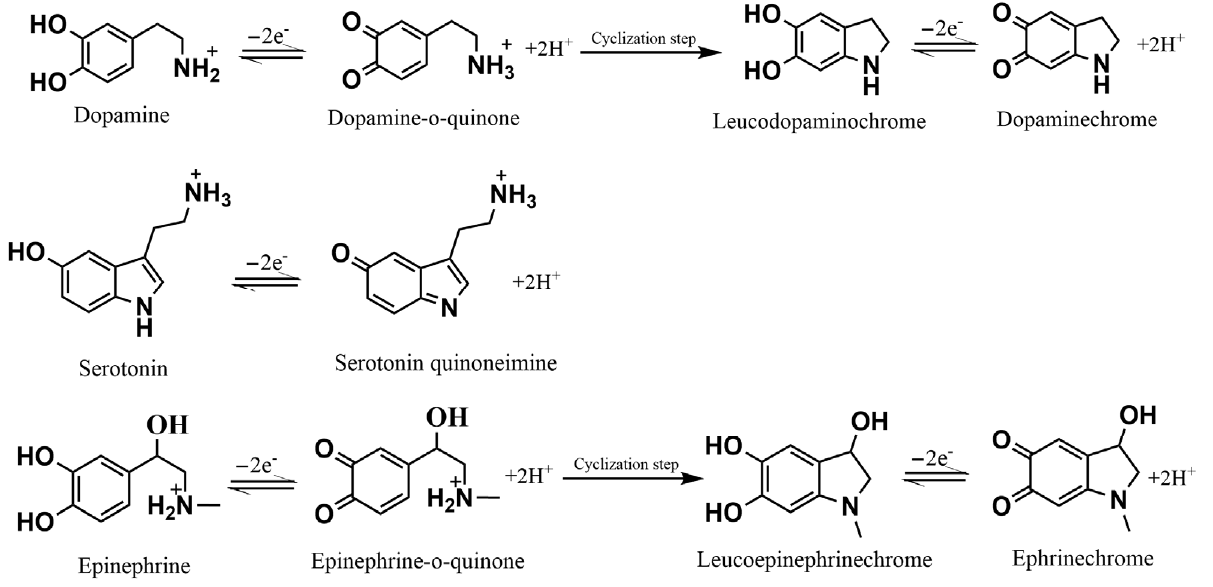
Figure 2. The general oxidation mechanisms of DA, SER and EPI.